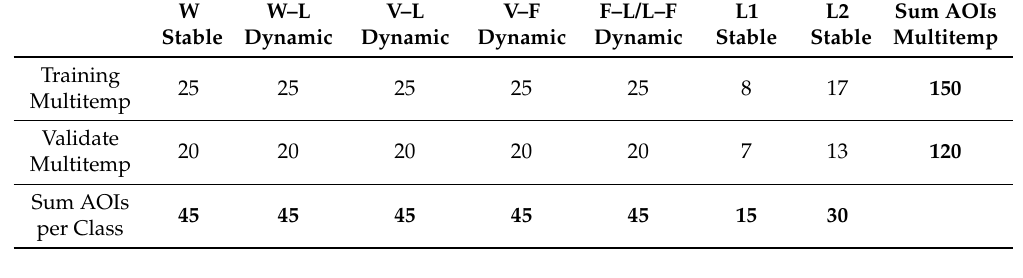
Table 5. Multitemporal AOIs for the training and validation dataset: W (water); W–L (water to land/soil); V–L (flooded vegetation to land/soil); V–F (flooded vegetation to irrigated fields); F–L/L–F (irrigated fields to land/soil or land/soil to irrigated fields); L1 (land: permanent vegetation); L2 (land: soil, rock, urban).